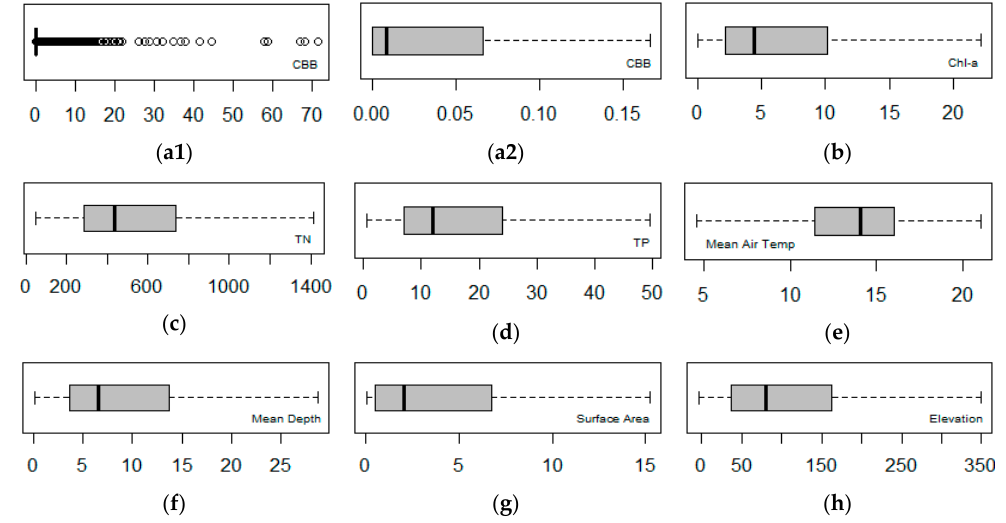
Figure 3. Box plots of the biochemical and geomorphological variables across the subset of the WISER lakes database: ( a1 ) CBB; ( a2 ) CBB after outlier filtering; ( b ) Chl-a; ( c ) TN; ( d ) TP; ( e ) mean air temp; ( f ) mean depth; ( g ) surface area; ( h ) elevation. Boxplots ( b ) to ( h ) present data after outlier filtering. All box plots are displayed by filtering the outliers except for CBB (Figure 3a1). The latter shows